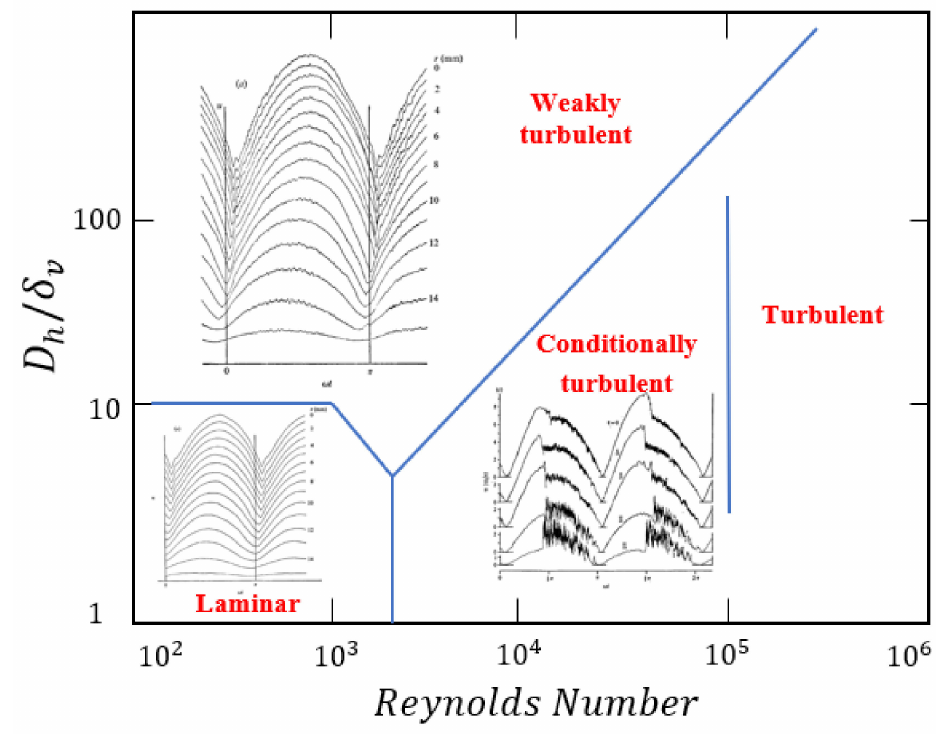
Figure 6. Qualitative boundaries of turbulent regimes in oscillating flows based on the results of Hino et al. [62] and Swift’s reproduction [8]; velocity waves are always positive because an anemome- ter cannot detect the oscillating flow